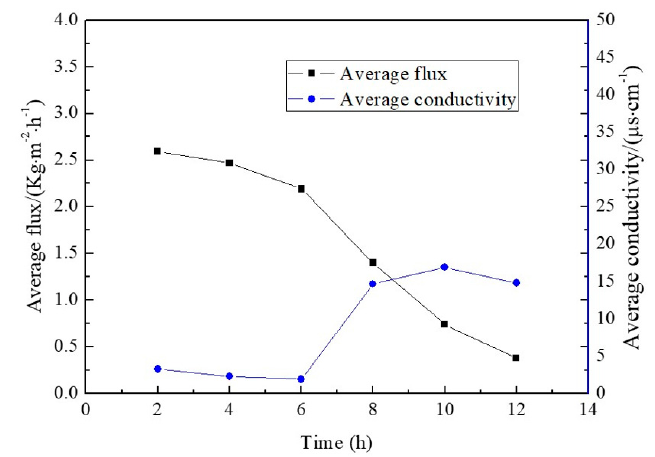
Figure 10. Evolution of membrane distillation flux and water yield conductivity of the mixed solution.